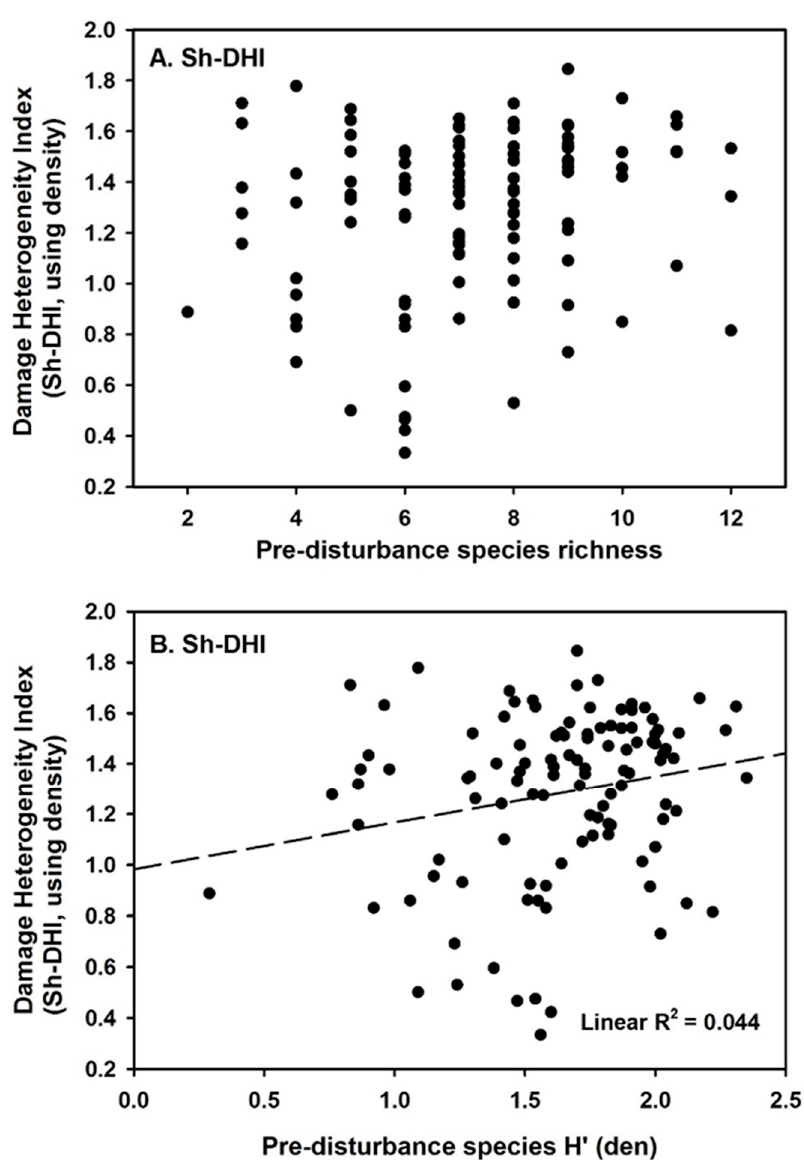
Figure 4. Damage heterogeneity index (DHI) vs. pre-disturbance plot species richness or diversity, for plots with 10-cm diameter minimum. ( A ) DHI calculated with Shannon formula, vs. species richness; ( B ) DHI calculated with Shannon formula, vs. pre-disturbance species diversity calculated using density and the Shannon formula. Only significant regressions shown.